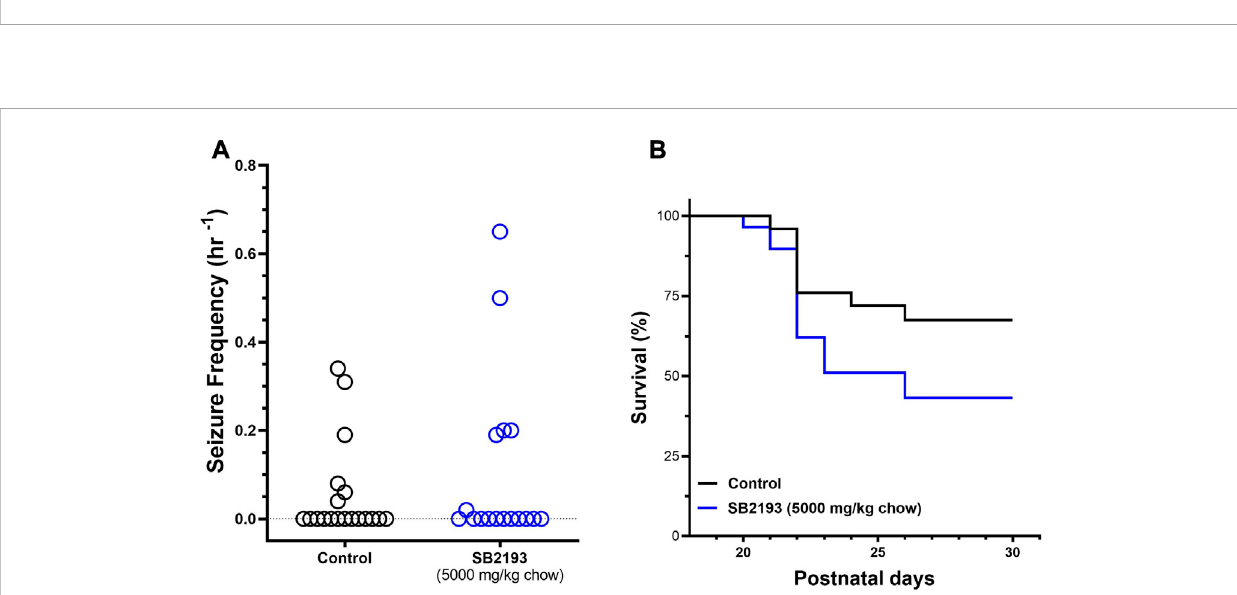
FIGURE 6 SB2193 treatment in Scn1a +/ − mice. Spontaneous generalised tonic-clonic seizure (GTCS) frequency of individual untreated and SB2193-treated Scn1a +/ − mice (A) . Treatment was administered orally through supplementation in chow (5,000 mg/kg chow) from postnatal day 18 and spontaneous GTCSs were quanti fi ed over 48 h from postnatal day 23 – 24. Sub-chronic SB2193 treatment had no effect on spontaneous seizure frequency ( p = 0.67, Mann-Whitney U test, n = 17 – 19). Survival curves comparing untreated and SB2193-treated Scn1a +/ − mice (B) . SB2193 treatment had no effect on survival of Scn1a +/ − mice to P30 ( p = 0.09, Mantel-Cox log